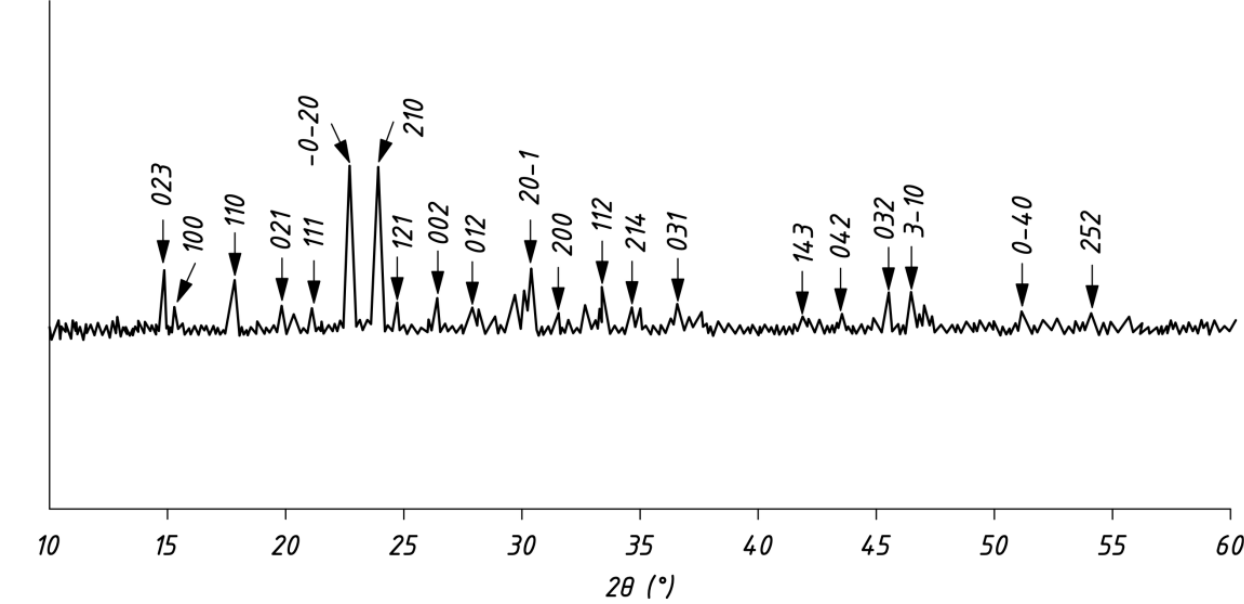
Figure 2. X-ray diffractometry analysis of mussel shell powder. (Intensity is diffraction intensity in a.u.‒arbitrary units, 2θ is diffraction angle).